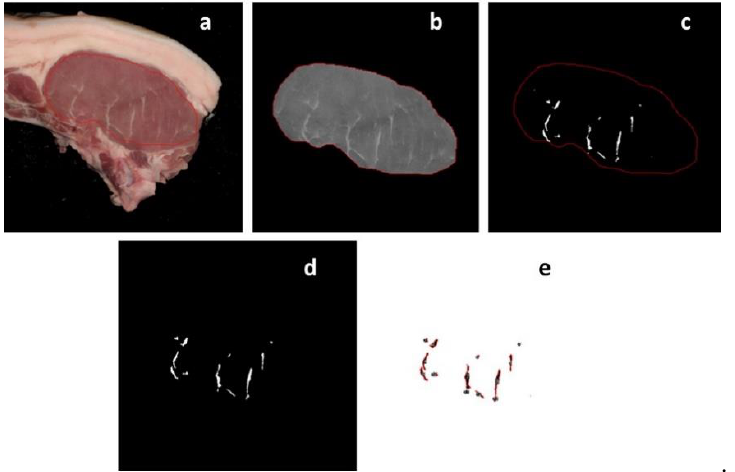
Figure 2. Steps of image analysis for the marbling fleck determination. ( a ) Original cutlet image with the region of interest (ROI); ( b ) clear outside the ROI and transform in a gray scale 8-bit image; ( c ) marbling fleck isolation after application of a threshold in a gray scale 8-bit image; ( d ) marbling fleck particles segmentation; and ( e ) numerical data extract.